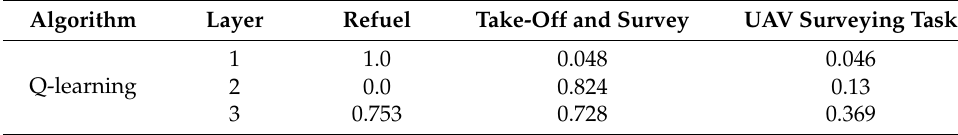
Table 1. The average performance of each subtask per layer completion for Q-learning.